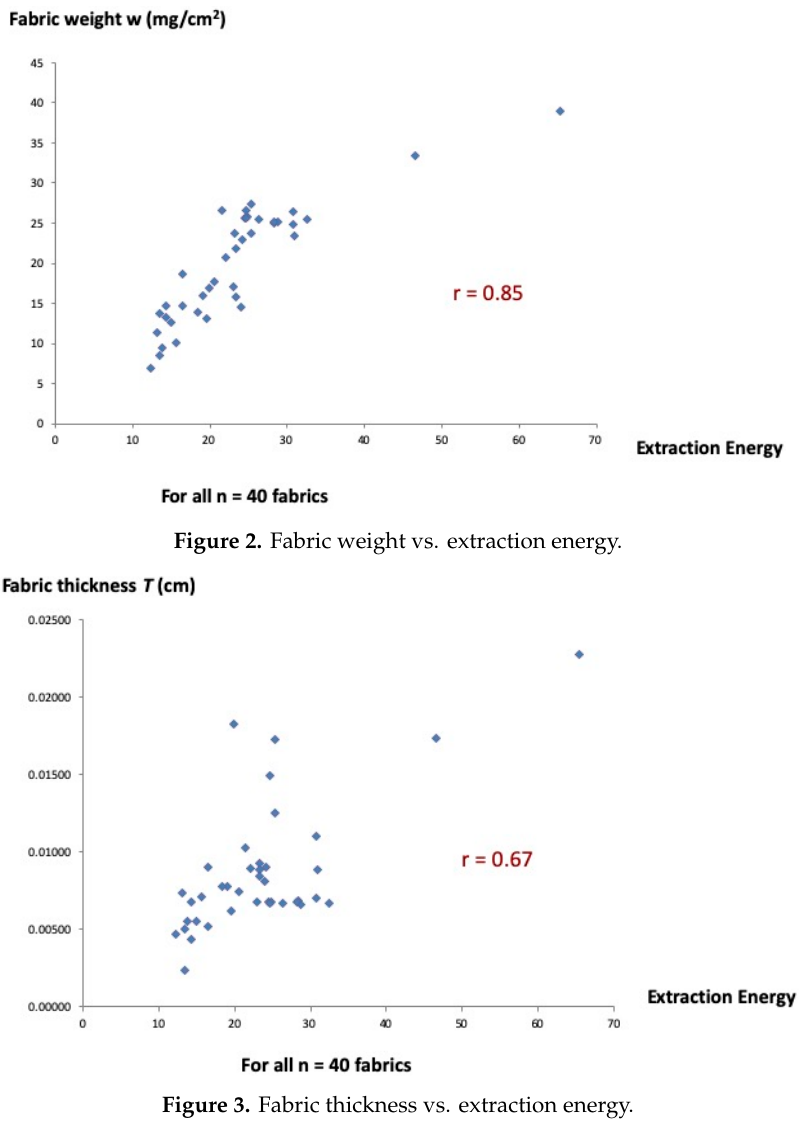
Figure 3. Fabric thickness vs. extraction energy.